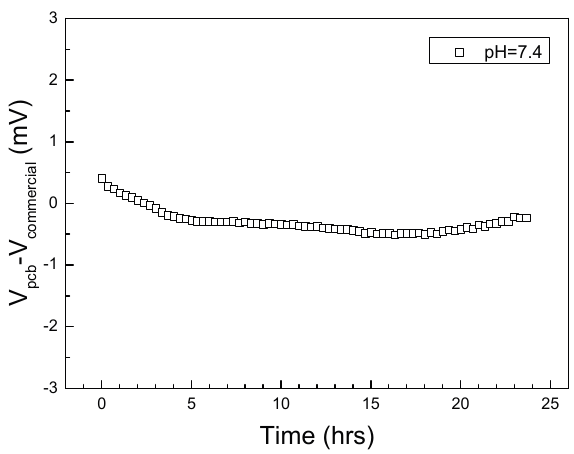
Figure 8. Voltage difference between PCB (Printed Circuit Board) pseudo-reference electrodes and commercial Ag/AgCl reference electrodes V pcb -V commercial evolution with time under constant flow (2.5 μ L/min) of HEPES buffer (pH =